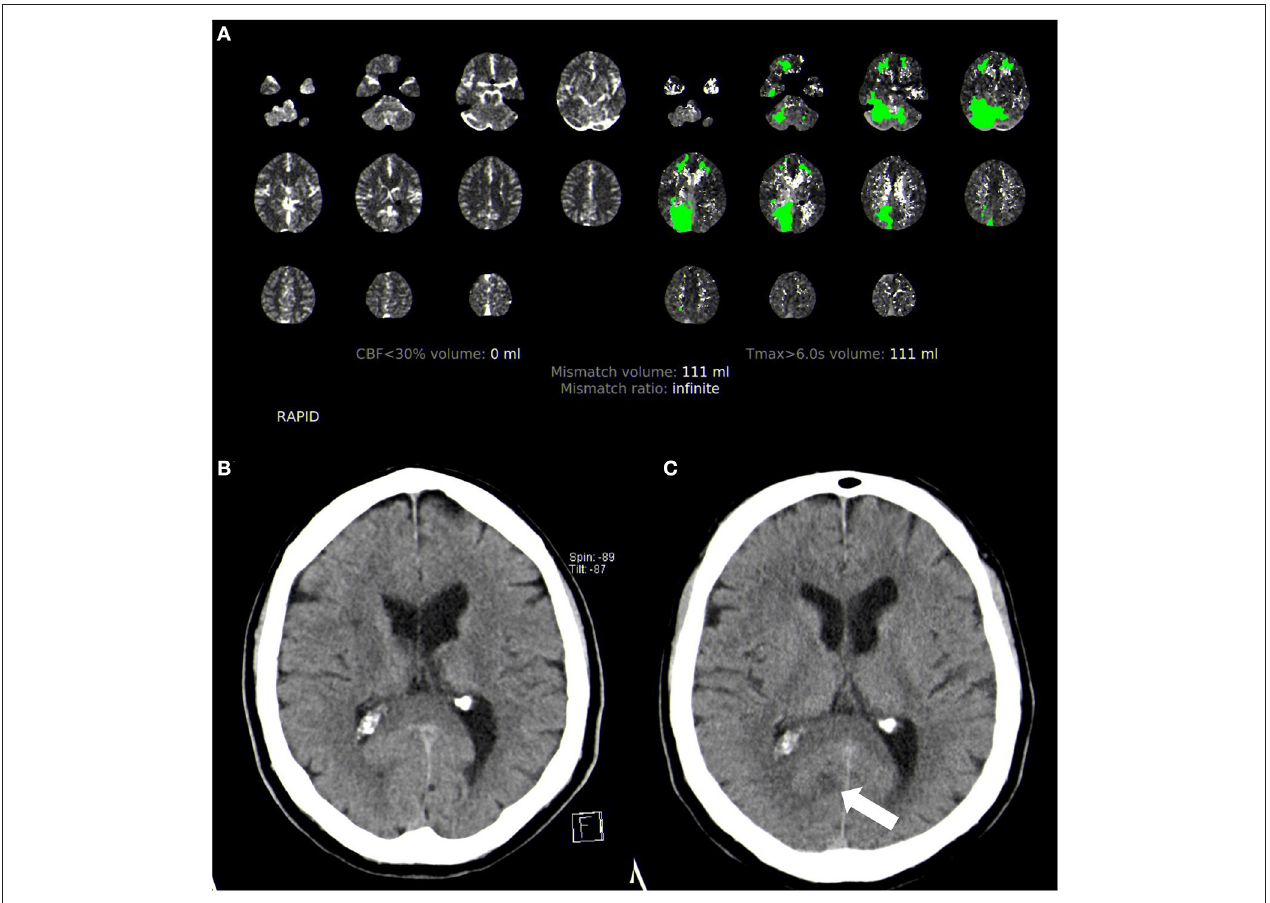
FIGURE 1 | Acute multimodal CT and follow-up non-contrast CT imaging in posterior circulation stroke. (A) Perfusion CT analyzed with Rapid CTP. (B) Initial non-contrast CT showing no infarction. (C) Follow-up non-contrast CT with a visible small infarction in the posterior cerebral artery territory (arrow).